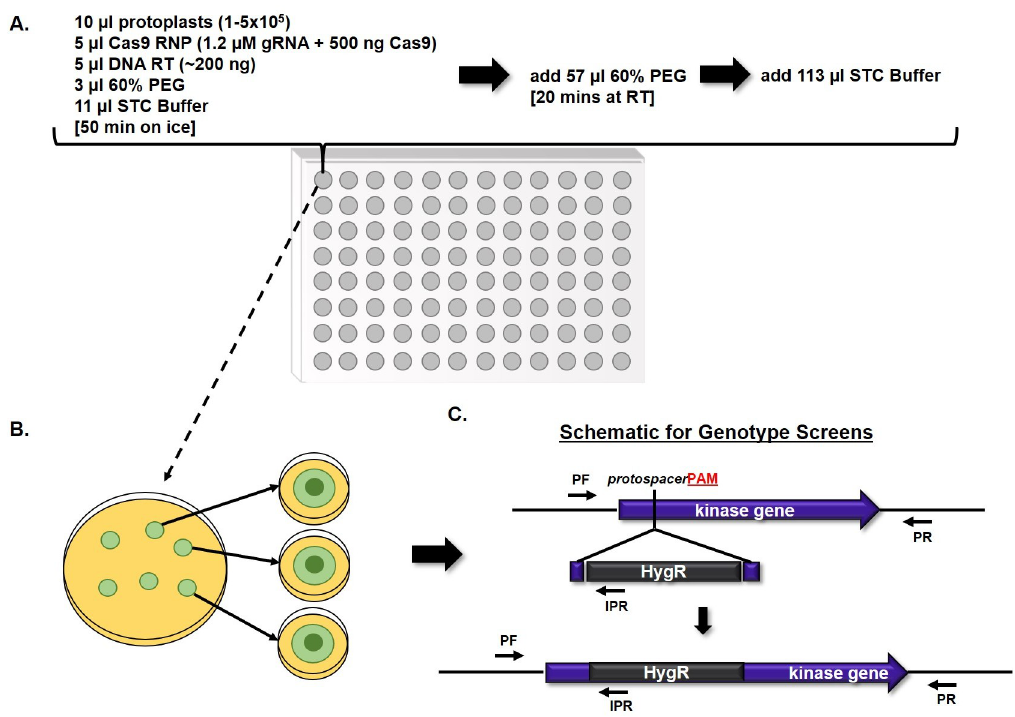
Fig 1. Construction of a protein kinase disruption library in A . fumigatus by CRISPR/Cas9-mediated gene editing. A) Miniaturized protoplast transformations were carried out in 96-well plates, with a final total volume of 200 μ l per well, and each well representing an attempted disruption of a single protein kinase gene. B) After the transformation process, the entire contents of each well were spread onto individual sorbitol minimal medium (SMM) agar plates and allowed to recover overnight at room temperature before overlaying with hygromycin-containing top agar for selection. Following these transformation procedures, typically 10 to 30 transformant colonies were evident on each selection plate after 3 to 4 days of incubation at 37˚C. However, due to the high efficiency of gene targeting with the CRISPR/Cas9 system, only 3 to 4 colonies per transformation were required to be isolated for genotypic screening. C) Putative transformants were subjected to genotypic analyses by PCR to confirm proper integration of the repair template for gene disruption. These PCR analyses included screens with allele specific primer sets PF/PR and PF/IPR, pictured above. PF = Forward screening primer. PR = Reverse screening primer. IPR = Internal reverse screening primer complementary to HygR sequence. HygR = Hygromycin Resistance cassette, utilized as the repair template for gene disruption. All kinase genes were targeted for disruption at the 5’ end of the gene (within the first exon, where possible), as indicated by the placement of the protospacer and protospacer adjacent motif (PAM, red bold font)